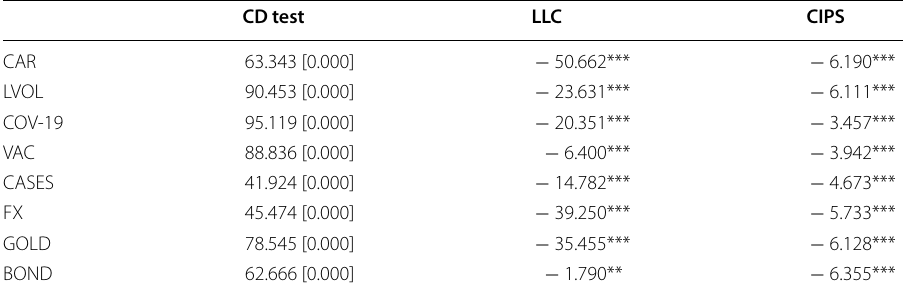
Table 4 Descriptive statistics